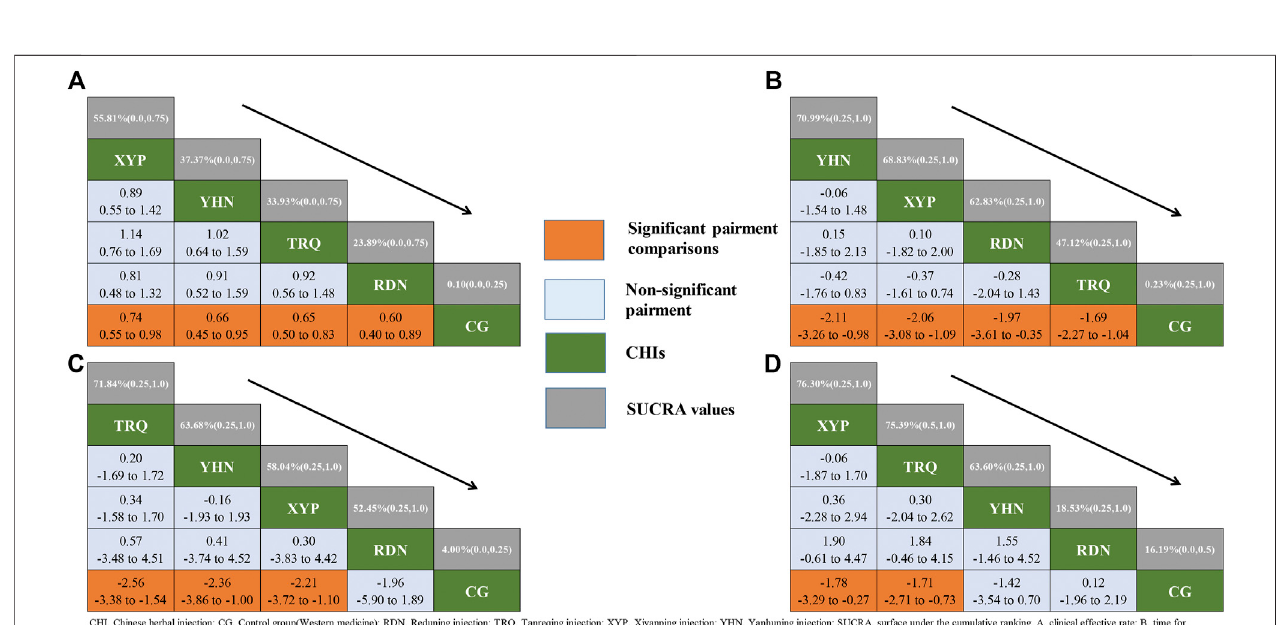
FIGURE 3 | Relative effect sizes of ef fi cacy at post-treatment according to network meta-analysis. CHI, Chinese herbal injection; CG, Control group (Western medicine); RDN, Reduning injection; TRQ, Tanreqing injection; XYP, Xiyanping injection; YHN, Yanhuning injection; SUCRA, surface under the cumulative ranking. (A) Clinical effective rate; (B) time for defervescence; (C) disappearance time of cough; (D) disappearance time of pulmonary rales; Highest probability of being the most ef fi cient CHI(With high SUCRA values) and Lowest probability of being the most ef fi cient CHI(With low SUCRA values).